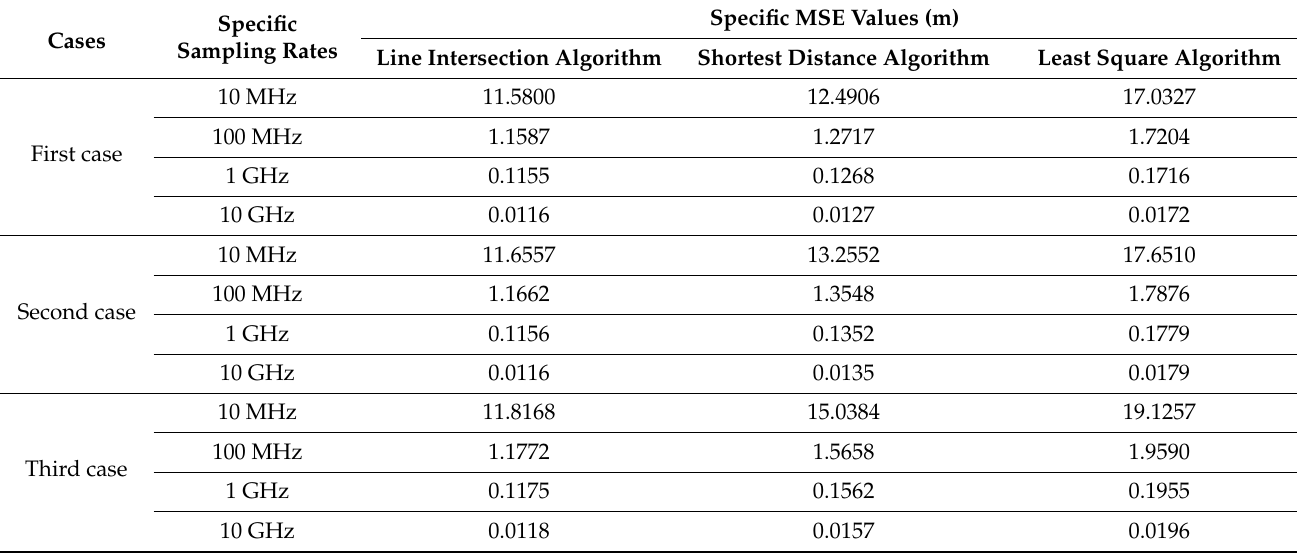
Table 3. Comparison between line intersection algorithm, shortest distance algorithm, and least square